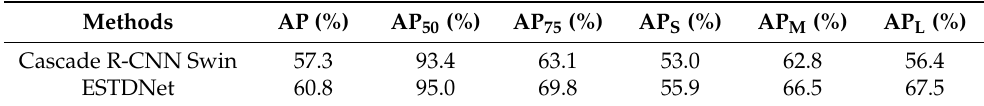
Table 4. The experimental result of ESTDNet on the SARShip